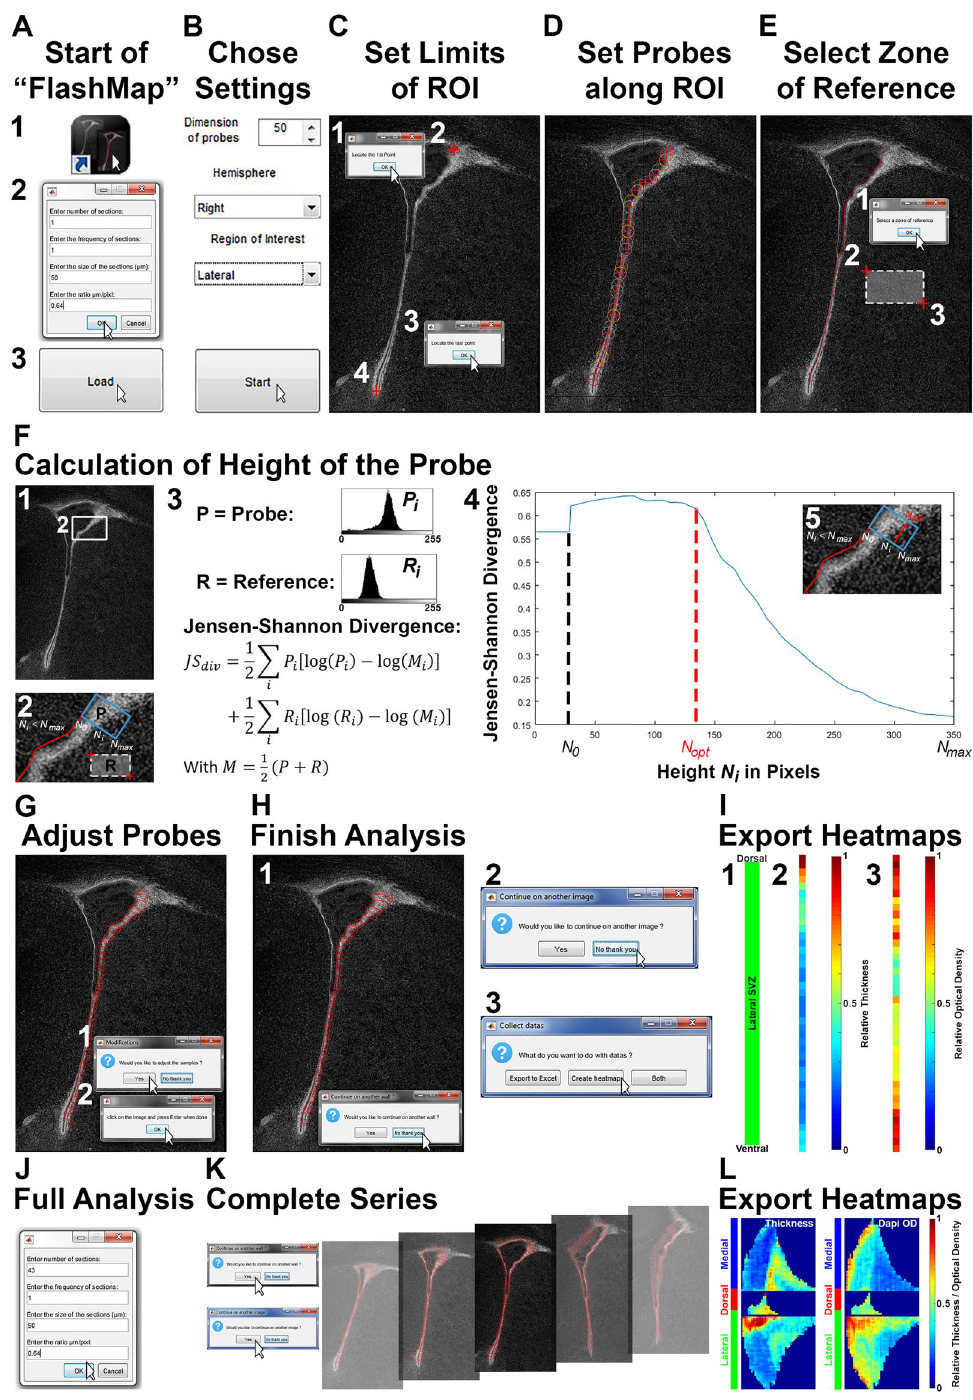
Figure 3. Detailed “FlashMap” walkthrough. (A) Start “FlashMap” and load images (1–3). For illustration, we chose to analyse a single microdomain in a single section. Define the thickness of the sections and the µ m/ pixels ratio (here 50 µ m and 0.64 µ m/pixel; 2). Load the image (3). (B) Define the dimension of the probes (here 50 µ m), the hemisphere (here “right” hemisphere) and the ROI (here “lateral” SVZ). (C) Define ROI by placing a “start point” (1, 2) and an “end point” (3, 4). (D) Draw the internal face of the ROI for automatic distribution of probes. (E) Define a reference area in the adjacent tissue (here striatum) by selecting two points in that region (1–3). (F) “FlashMap” automatically calculates the height of the probes according to the differential cell densities within the probe (P) and the selected reference region (R; 1, 2). Using JS div (3) the software estimates the optimal basal height of the probe ( N opt ; height of the probe in pixels, where the value of the JS div consistently drops) between the apical and the basal borders N 0 and N max , respectively (4, 5). (G) Probes can be adjusted manually. (H) Complete the analysis by declining the request to proceed with another ROI (1) and another section (2). Export values (Excel files) and/or heatmaps in TIFF format (3). (I) Heatmaps of the lSVZ